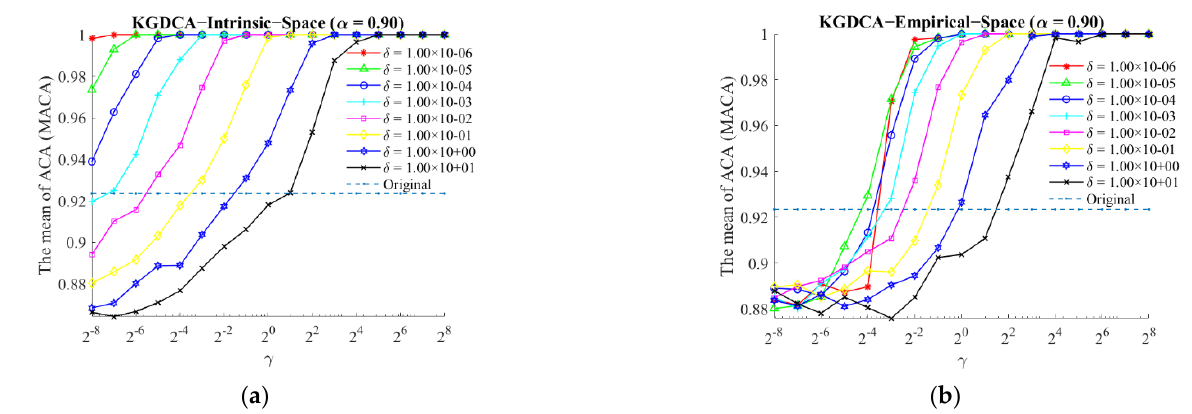
Figure 13. Comparisons of MACA between GDCA’s kernelization forms driven SVM and original SVM when α =